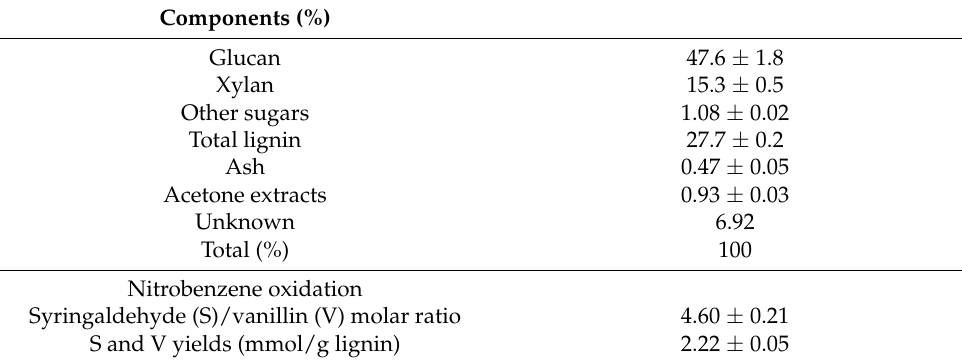
Table 1. Chemical composition of Eucalyptus globulus wood.